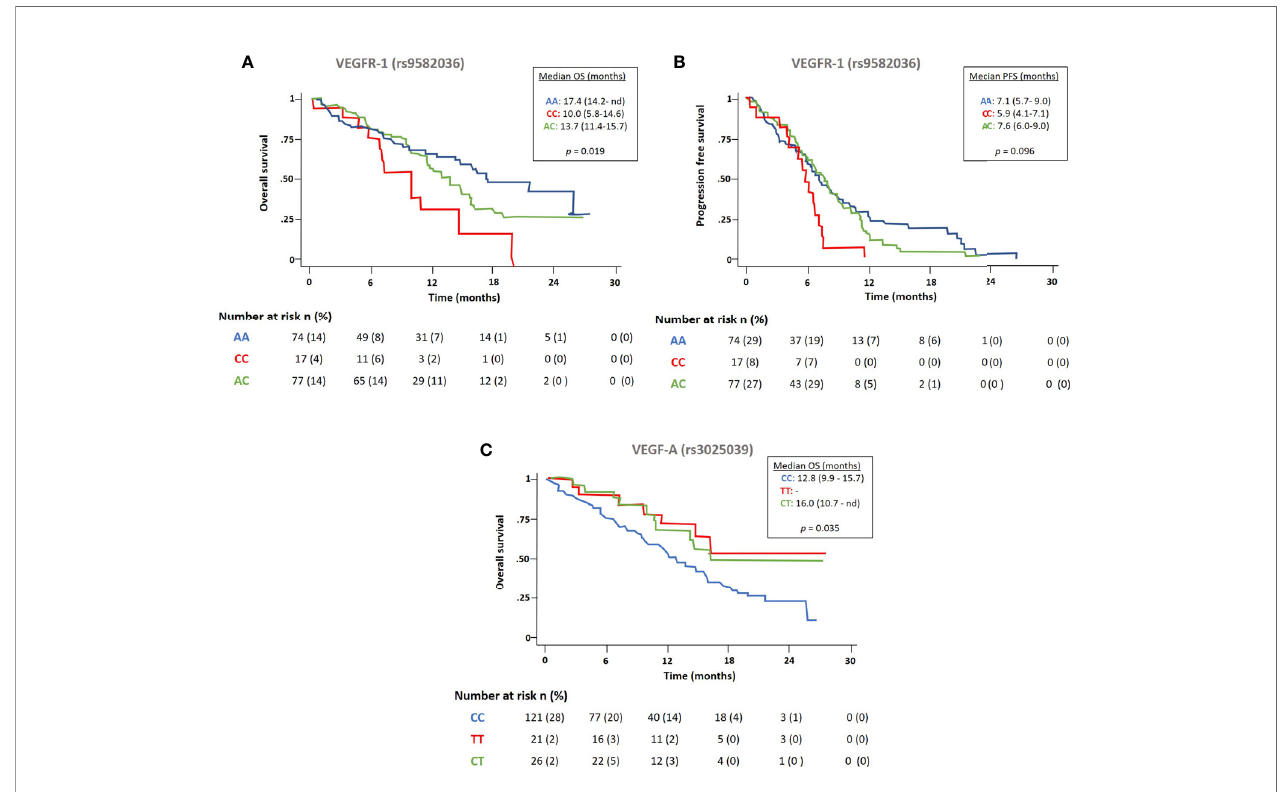
FIGURE 3 | Effect of the polymorphism in VEGFR-1 rs9582036 in estimated OS (A) and PFS (B) , and in VEGFA rs3025039 in estimated OS (C)